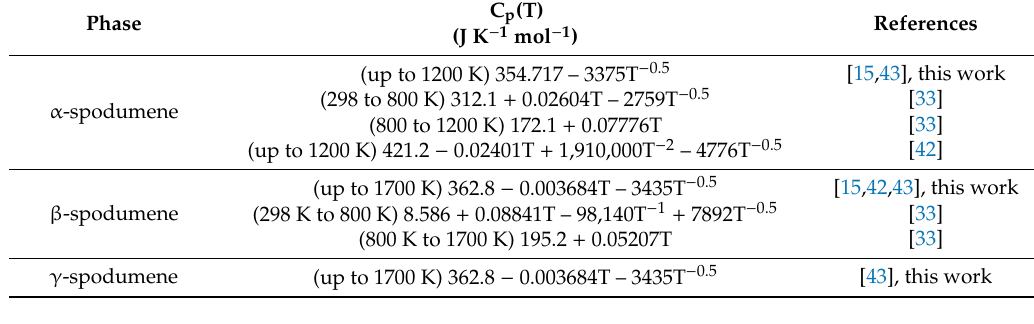
Table 8. Summary of spodumene phase data (C p (T)).